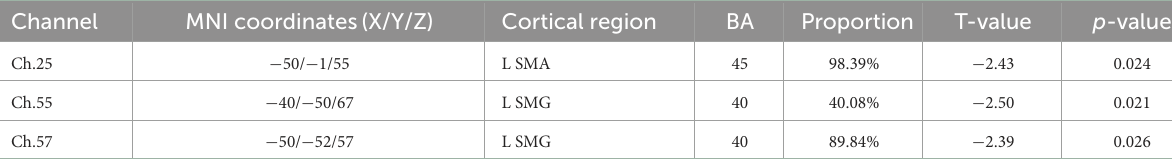
TABLE 4 Exact location and intensity of activation during phrase repetition